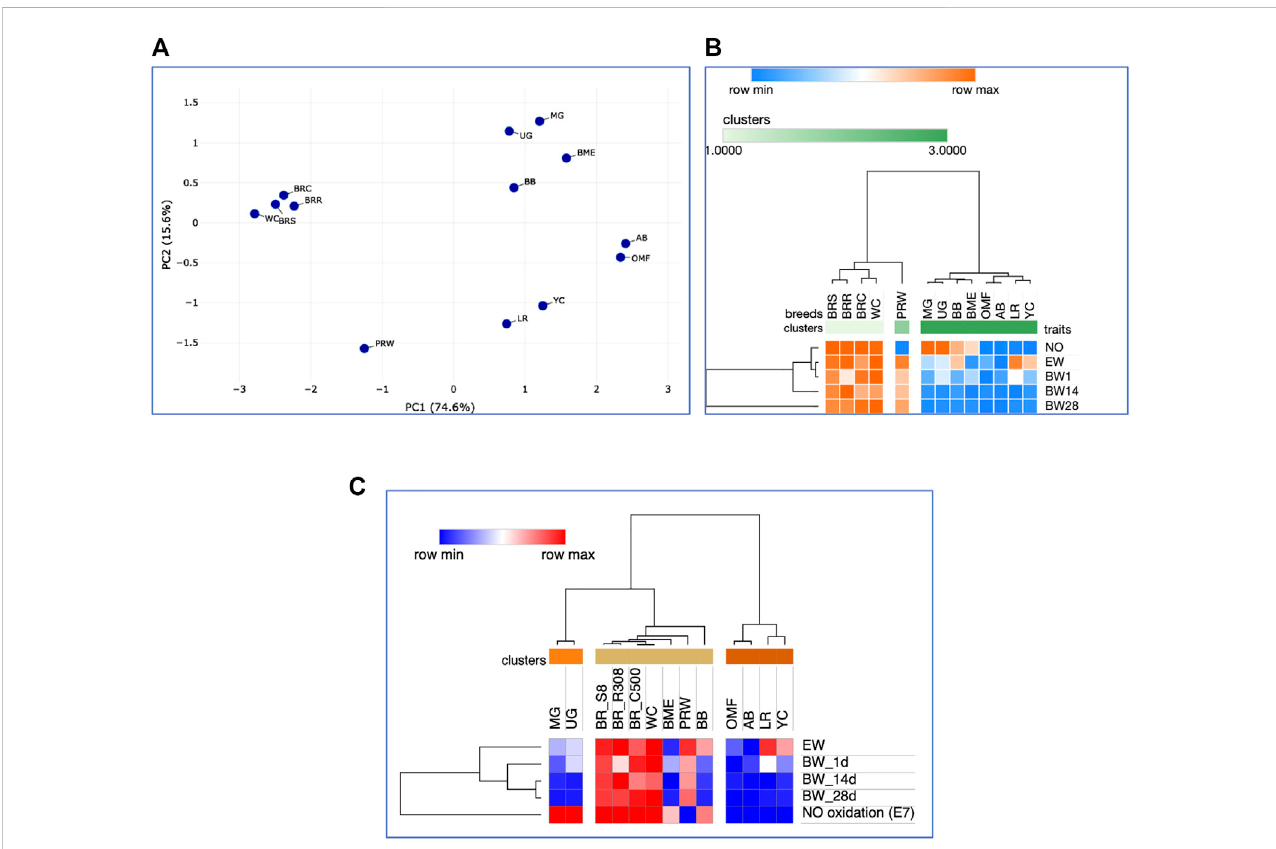
FIGURE 7 Analysis of thedistributionof13 thebreedsby traits ofE7 NO oxidation and postnatal growth, including EWand BWofchicksatthree ages, performed in the Phantasus program (Zenkova et al., 2018). (A) PCA plot. X and Y -axes show principal component 1 (PC1) and principal component 2 (PC2) that explain 74.6% and 15.6% of the total variance, respectively. N = 13 data points (breeds). (B) Heatmap and hierarchical clustering tree based on Euclidean distance metric (with the average option selected for the linkage method). (C) Heatmap and hierarchical clustering tree using one minus Pearson ’ s correlation metric (with the average option as linkage